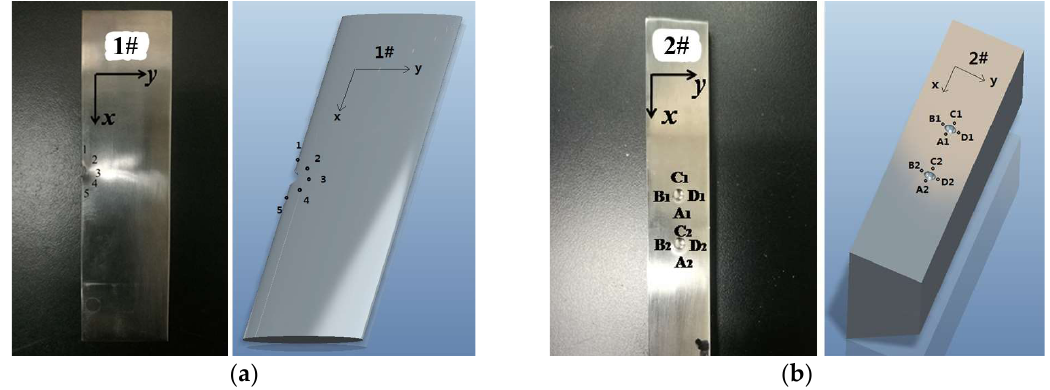
Figure 5. Two kinds of deformed Ti-6Al-4V samples: ( a ) Specimen 1# and its schematic diagram; and ( b ) Specimen 2# and its schematic diagram.